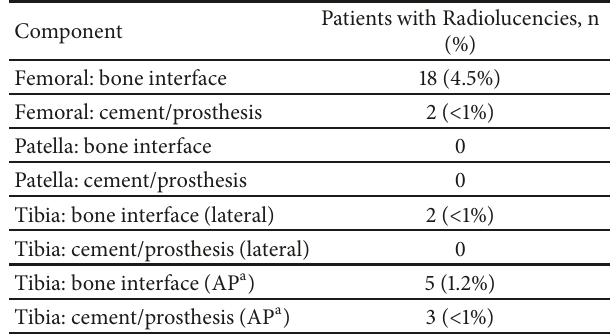
Table 4: Distribution of radiolucent